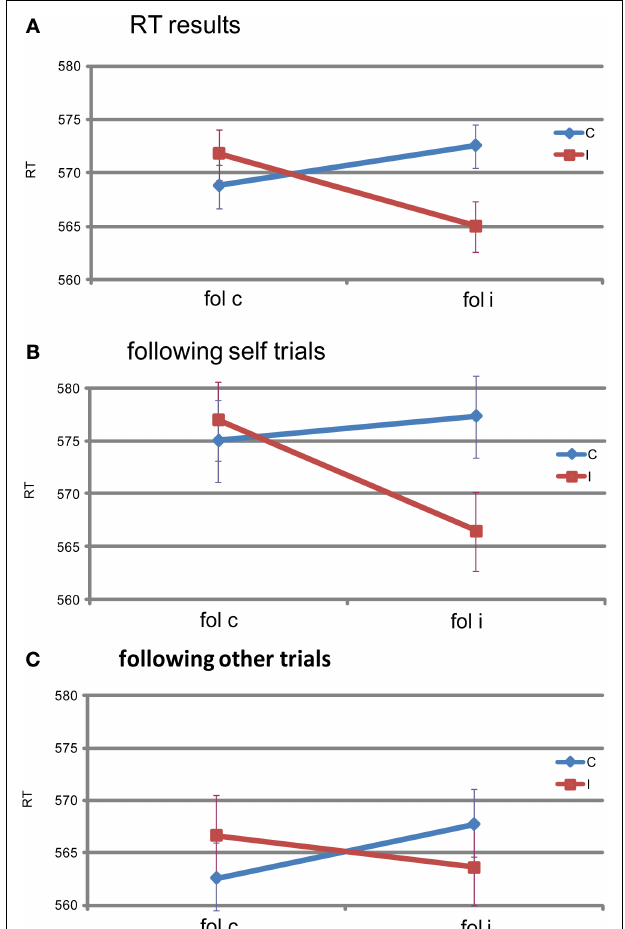
FIGURE 2 | Reaction time results. Shown here are the subjects’ average RT as a function of congruency of the previous trial ( x -axis) and congruency of the current trial (colored lines). (A) shows the RT data for all trials, (B) for the trials following self trials only, and (C) for trials following other trials only. The bars represent the standard error of the mean, computed over the RT normalized per subject (Loftus and Masson, 1994).